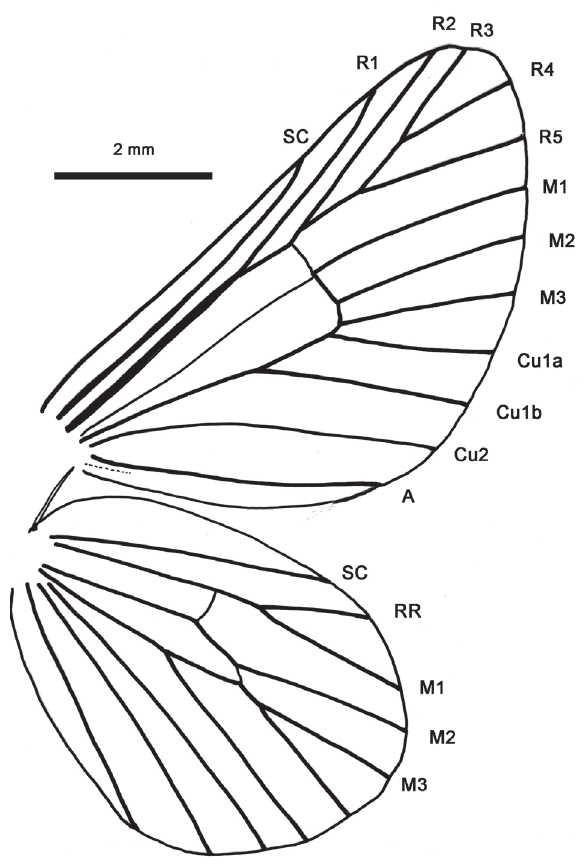
Figure 6. Vansoniella chirindensis sp. n., male wing